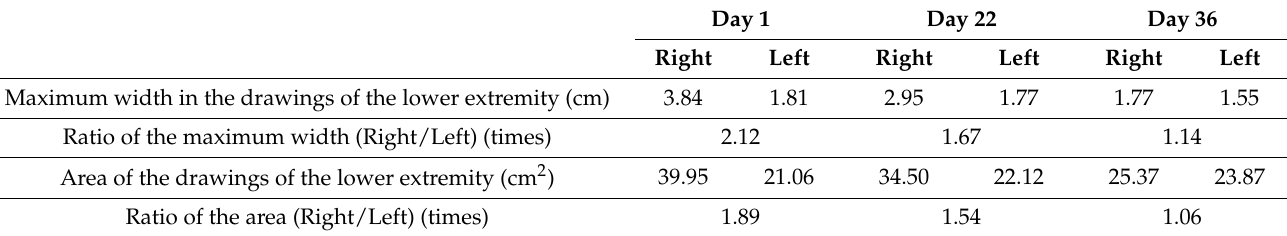
Figure 3. Line drawings of lower extremities in day 1 ( a ), day 22 ( b ), and day 36 ( c ).